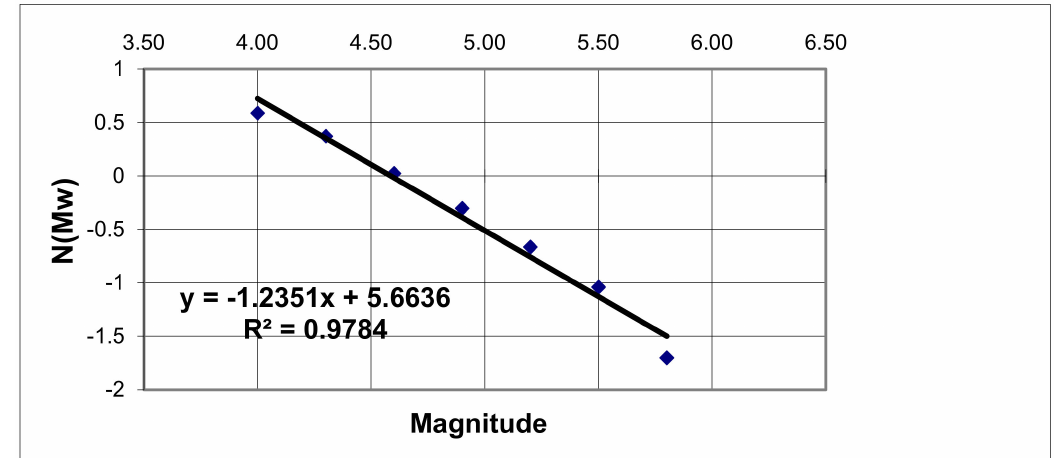
Figure 8. Gutenberg–Richter recurrence relationship curve for source zone 14.